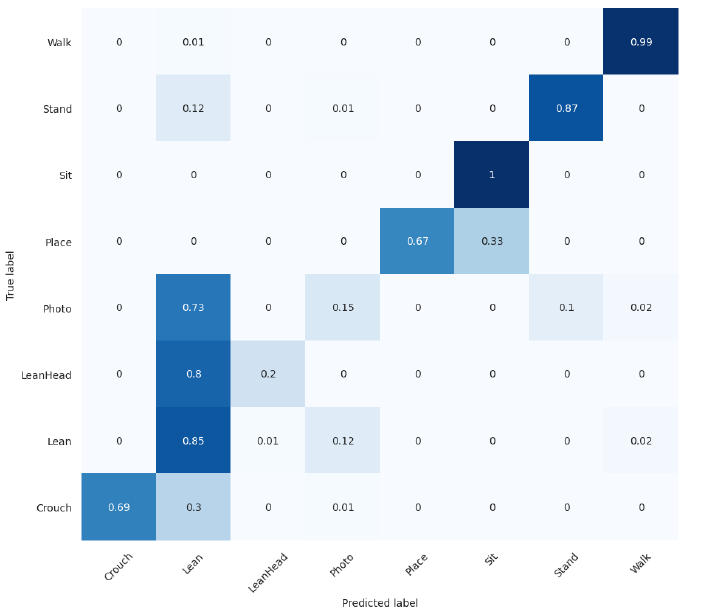
Figure 9. Confusion matrix of the action recognition task on CCTV dataset-split1 performed by the SlowFast network, with darker color indicates higher